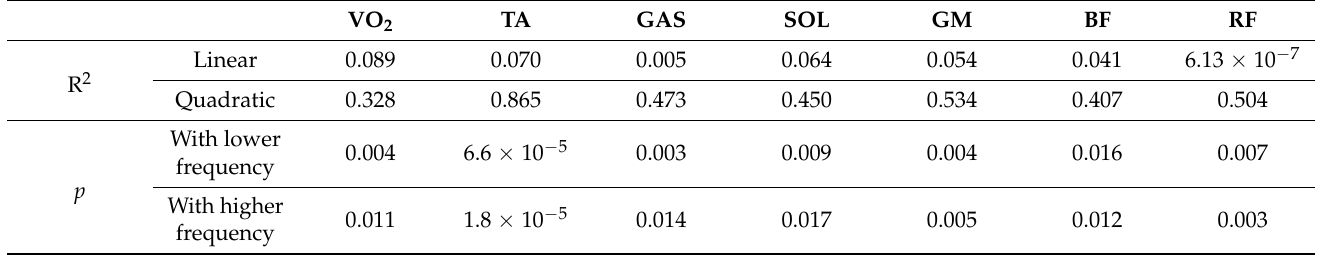
Figure 12. Mean and standard deviation of the muscle activity (as a percentage of the value for walking at the preferred step frequency) for the last two minutes of walking across the three different frequencies under the preferred condition. Step frequencies are plotted as the percentage difference from the preferred frequency, ∆ ω . The preferred frequency is ∆ ω = 0%. The solid line represents the quadratic curve with error bars of standard deviation. Each subplot is a different muscle under the preferred condition: ( a ) gastrocnemius muscle; ( b ) biceps femoris muscle; ( c ) rectus femoris muscle; ( d ) tibialis anterior muscle; ( e ) gastrocnemius muscle; ( f ) soleus muscle. Table 4. Results of modeling analysis for muscle activity and oxygen consumption and the differences between values at the preferred and other frequencies under preferred condition.